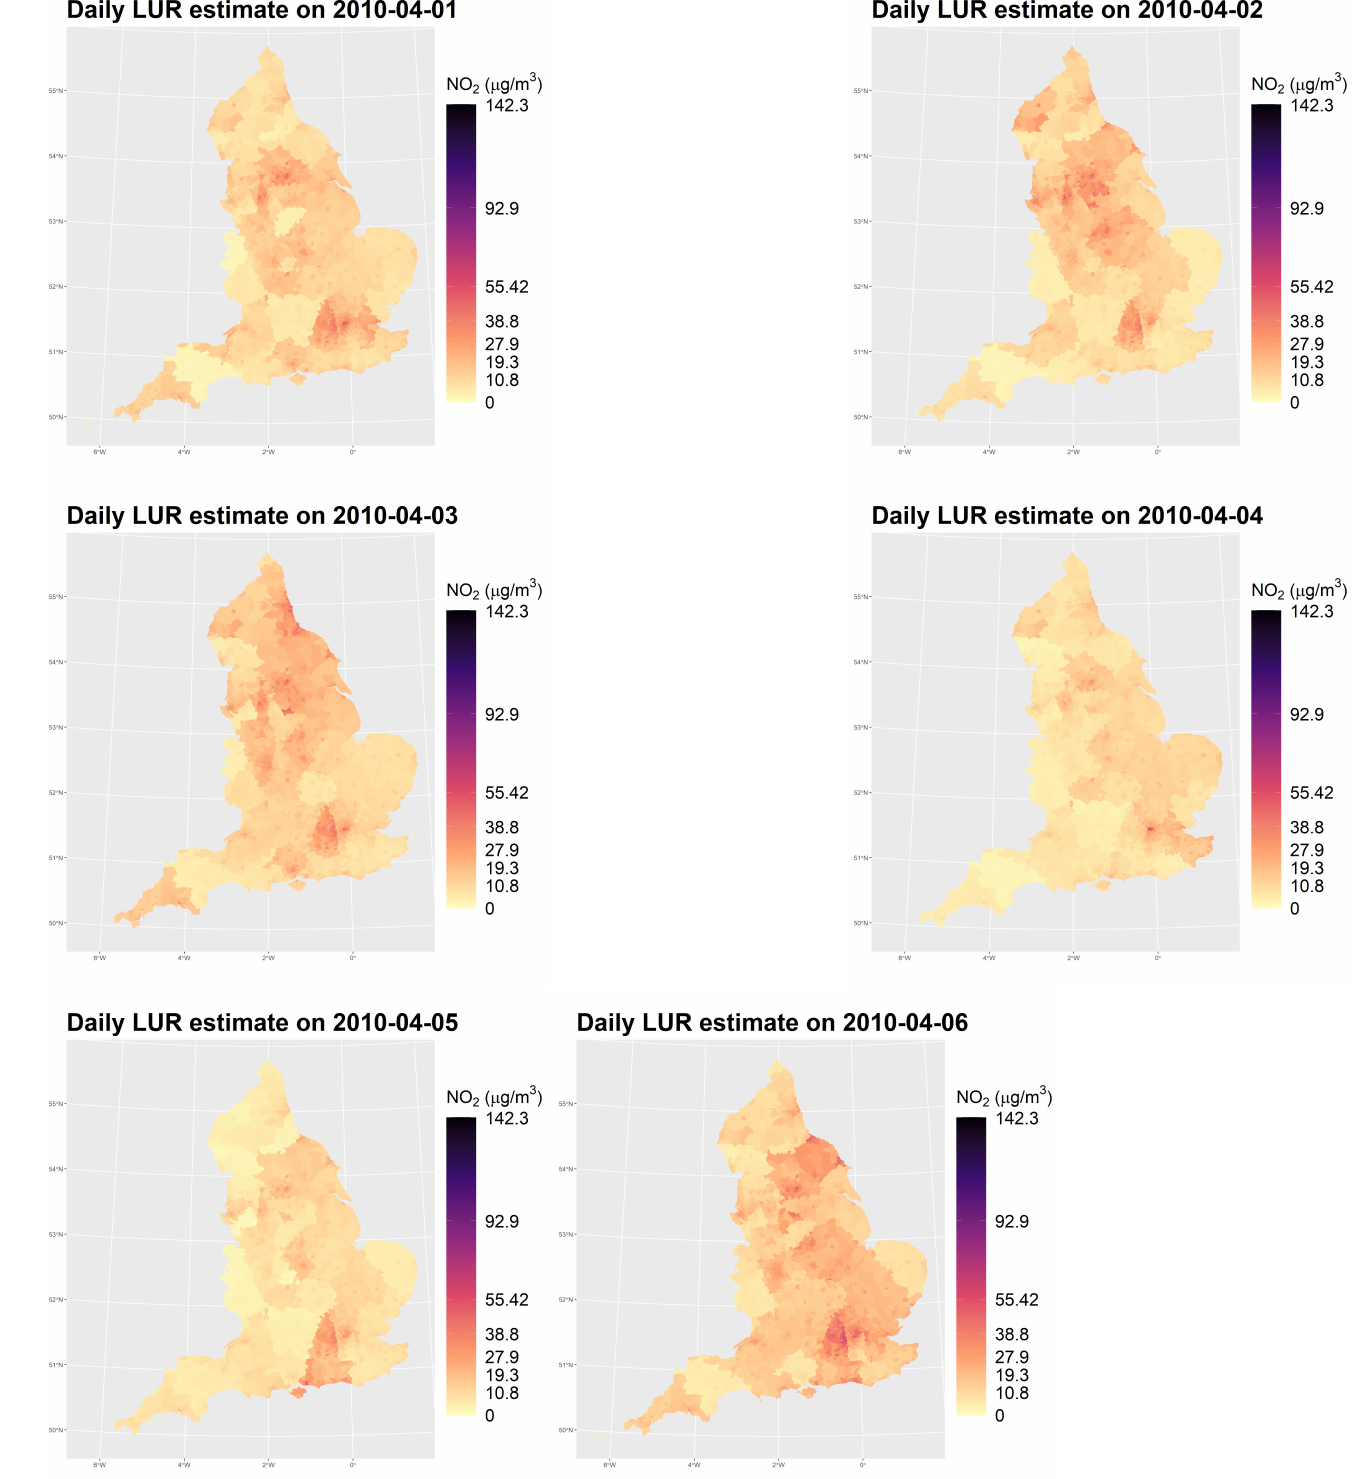
Figure A2. Daily NO 2 surfaces from 1 April 2010 to 10 April 2010, produced from the daily LUR model. The spatial unit is the postcode district. The maps demonstrate spatial variation across England and temporal variation across six consecutive days. For example, 6 April 2010 shows an elevated pollution level in most